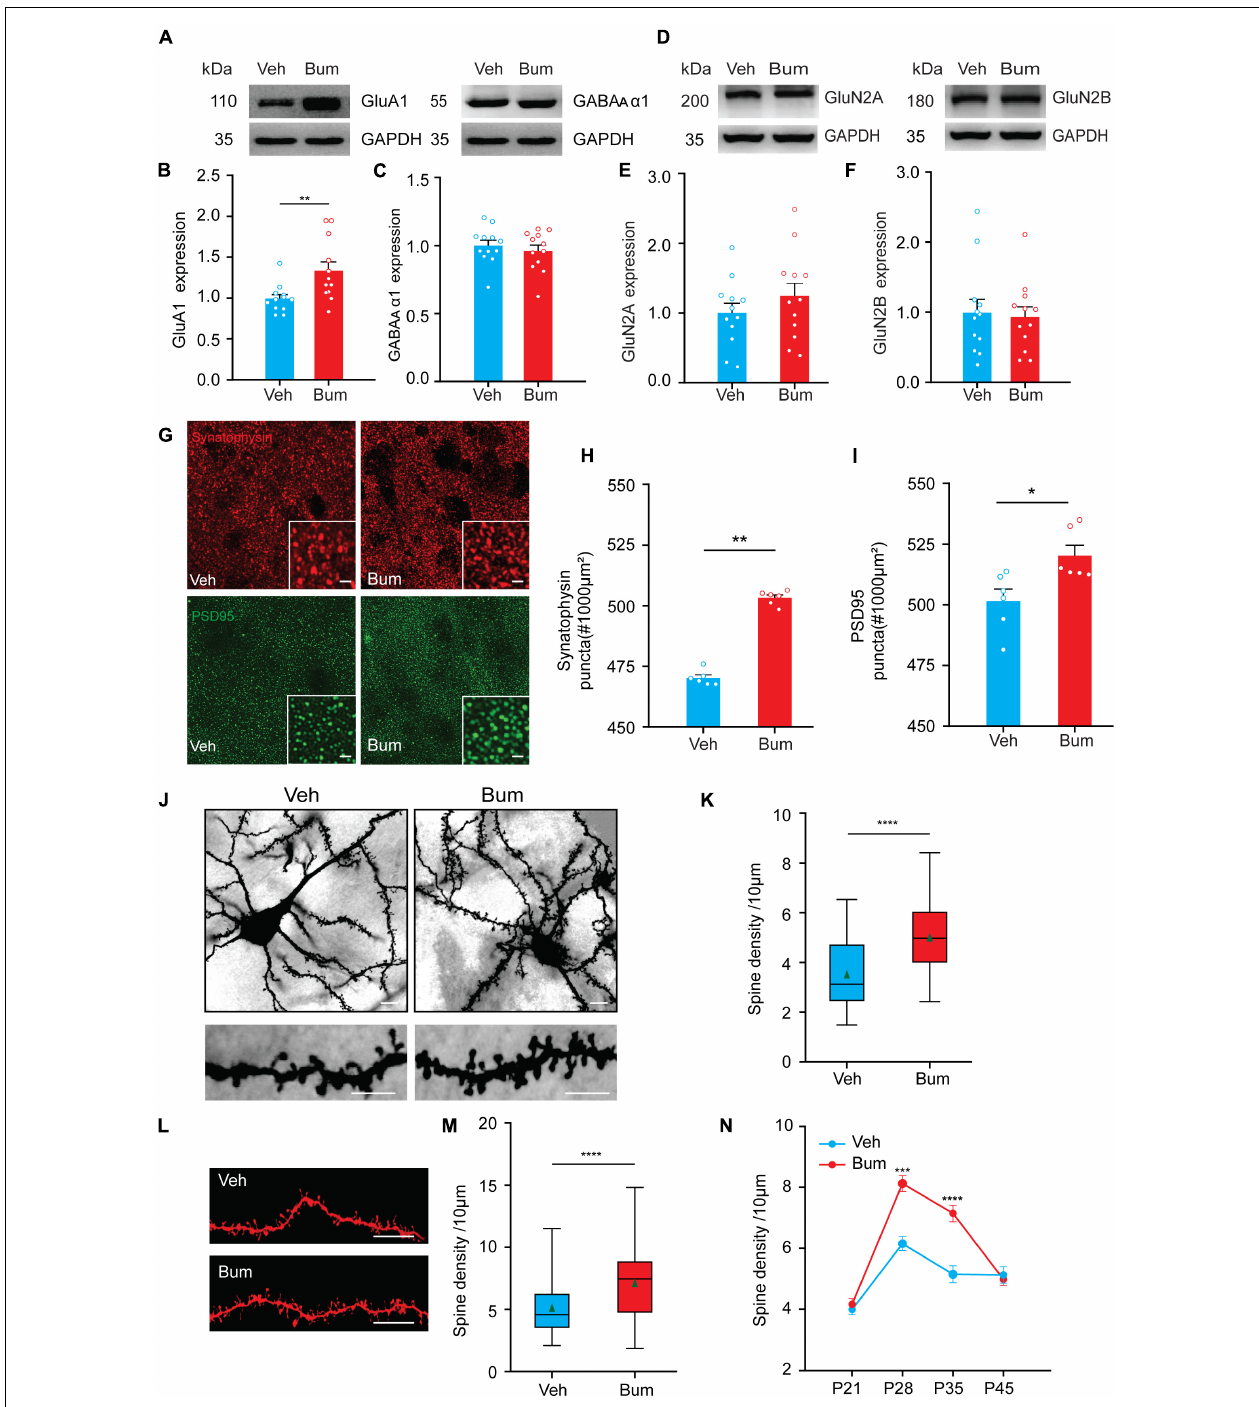
FIGURE 6 | Binocular mismatching of bumetanide treatment is accompanied by changes in neuronal synaptic properties. (A) Cropped images of immunoblotting for GluA1 and GABA A α 1 on protein extracts from P35 V1 of Veh and Bum mice. (B,C) Quantification of GluA1 and GABA A α 1 expression levels in Bum and Veh mice (GluA1: p = 0.0036; GABA A α 1: p = 0.78, 12 mice per group; Mann-Whitney rank-sum test). (D) Cropped images of immunoblotting for GluN2A and GluN2B on protein extracts from P35 V1of two groups. (E,F) Quantification of GluN2A and GluN2B expression levels in Bum and Veh mice (GluN2A: p = 0.48; GluN2B: p = 0.97, 12 mice per group; Mann-Whitney rank-sum test). GAPDH was used as the internal standard. Each circle indicates individual mouse. (G) Confocal images (60 × , single plane) show synaptophysin (SYN) (red) and postsynaptic PSD-95 (green) proteins in V1b from Bum and Veh mice at P35. Insets in the lower right corner of the images are 2 × zoom-in views of SYN and PSD-95 puncta. Scale bar, 5 µ m. (H,I) Quantification of synaptophysin and PSD-95 positive puncta in the